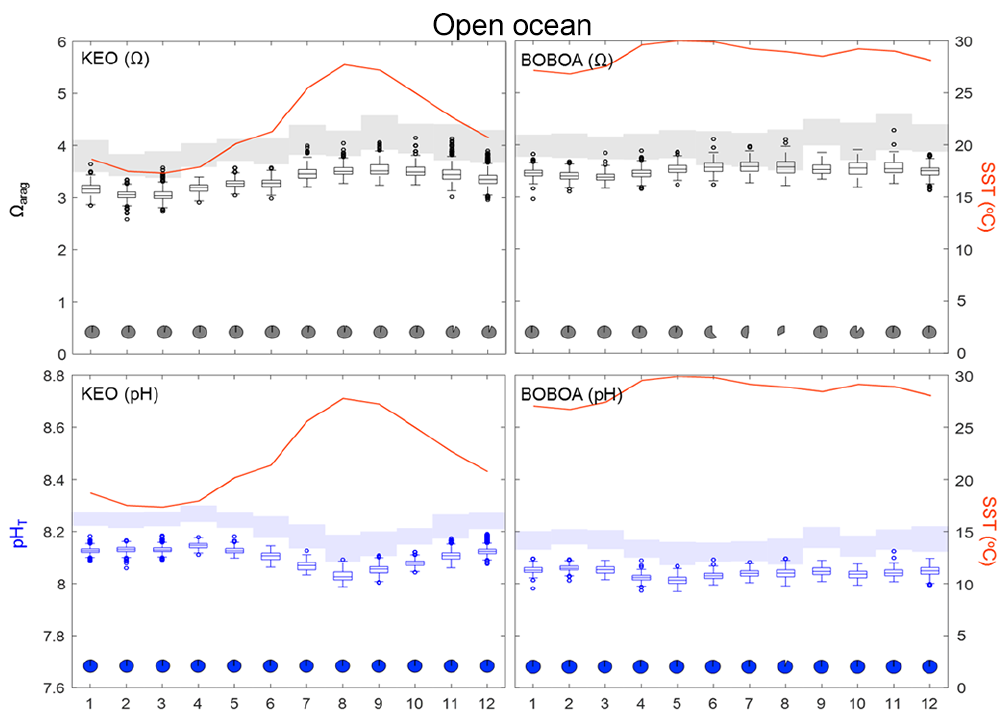
Figure 3. Box and whisker plots of present-day monthly surface seawater (cid:127) arag (top) and pH (bottom) and monthly mean SST at the open ocean mooring locations in biologically productive subtropical regions that experience seasonal monsoons (BOBOA) and tropical cyclones (KEO). See detailed description of figure components in Fig. 2